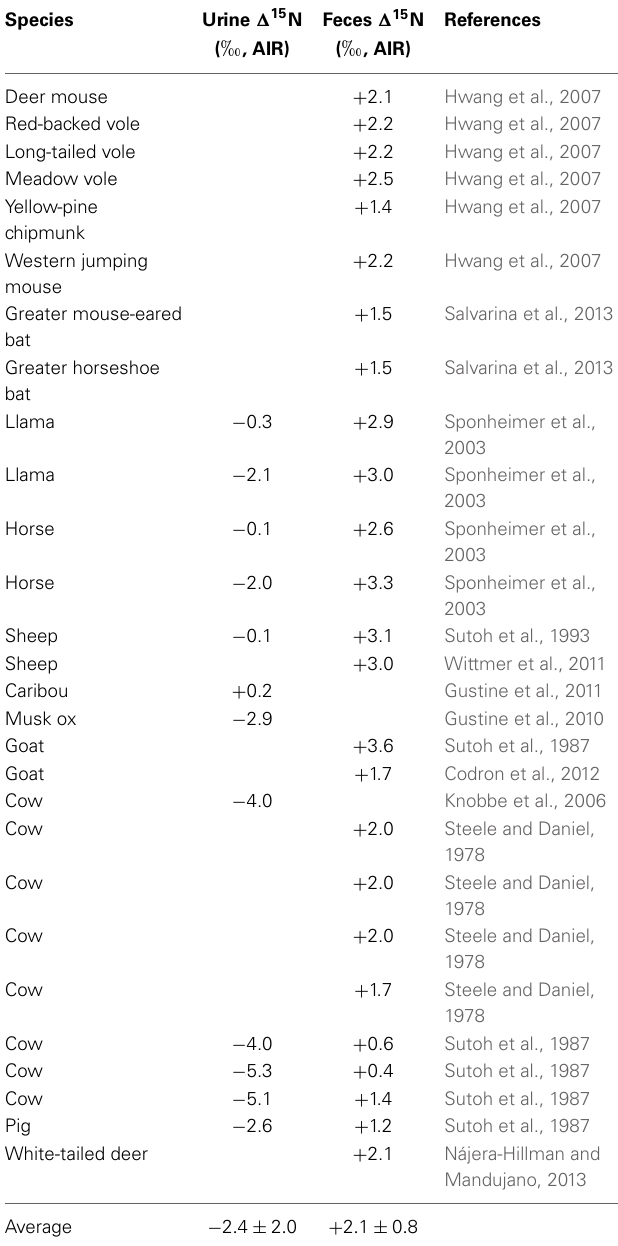
Table 1 | Summary of studies presenting data for the differences in N isotopic compositions between the diet and urine and/or diet and feces ( (cid:3) 15 N) of different mammalian